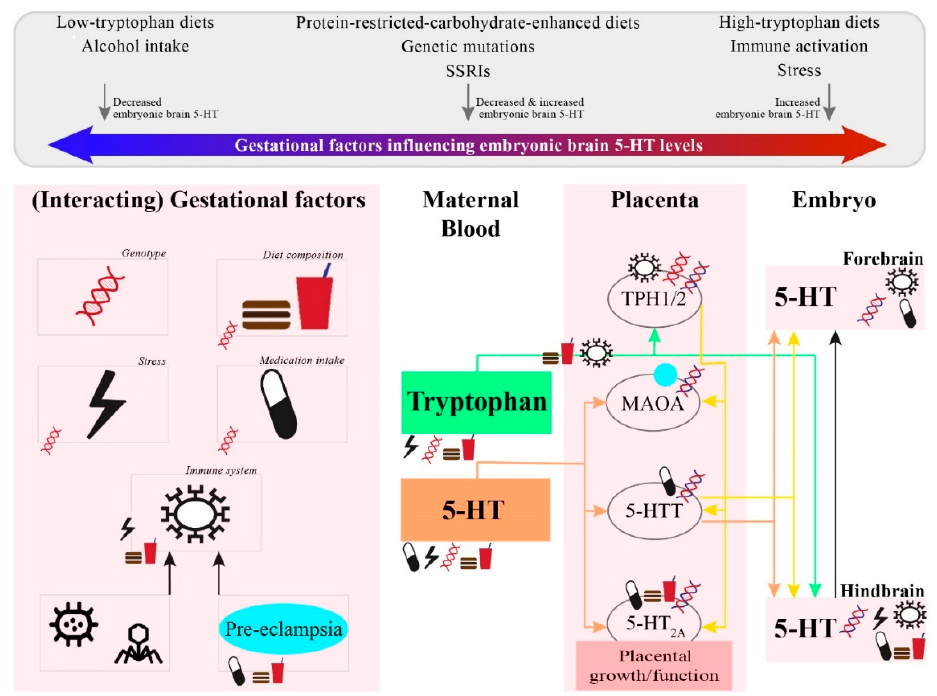
Figure 2. Schematic overview of the e ff ects of (interacting) gestational factors on 5-HT levels during the embryonic period. Gestational factors (i.e., maternal 5-HT-ergic genotype, 5-HT-related diets, stress exposure, 5-HT-ergic medication intake, and immune activation) decrease (top arrow blue, left) or increase (top arrow red, right) embryonic brain 5-HT levels. The gestational factors in the middle (purple) have been found to increase as well as decrease brain 5-HT levels in the embryo. Gestational factors do not only independently a ff ect the embryonic brain 5-HT system but are also able to interact and thereby amplify or counteract each other’s impact on the embryonic brain 5-HT system. Maternal genotype is able to influence the e ff ects of maternal diet composition, stress, and medication intake. The maternal immune system is activated by bacteria, viruses, and pre-eclampsia (blue dot) and is influenced by maternal stress and diet composition. Furthermore, the risk of pre-eclampsia is influenced by maternal medication intake and diet composition. Gestational factor influences on the embryonic brain 5-HT system are a consequence of changes in placenta-derived (maternal blood or placenta) and / or o ff spring’s raphe-produced (hindbrain) 5-HT content. Factors can influence maternal tryptophan levels, which influence tryptophan transfer to the embryo and placental 5-HT synthesis (green arrows). In turn, placental 5-HT synthesis alterations influence the transfer of 5-HT to the embryo (yellow arrows). Maternal 5-HT levels can influence placental 5-HT levels and transfer to the embryo as well (orange arrows). It should be mentioned that the placenta also express MAOA and the 5-HT 2A receptor, which can breakdown the supplied / synthesized 5-HT and a ff ect the placental structure and function, respectively. Gestational factors can influence the placental 5-HT system by targeting TPH1 / 2, MAOA, 5-HTT, and / or the 5-HT 2A receptor. Some of these factors also influence the embryonic brain 5-HT system. These direct e ff ects are evident in the fore- and hindbrain and include fetal 5-HT-ergic genotype, the placental transfer from 5-HT-ergic medications, activation of the embryonic immune system, and alterations in the raphe-produced 5-HT content due to maternal stress (placental CORT transfer) and maternal diet. These factors can influence the maternal and placental pathway at multiple levels: altering maternal tryptophan and 5-HT levels, placental 5-HT synthesis, or the placental transfer from tryptophan and 5-HT to the